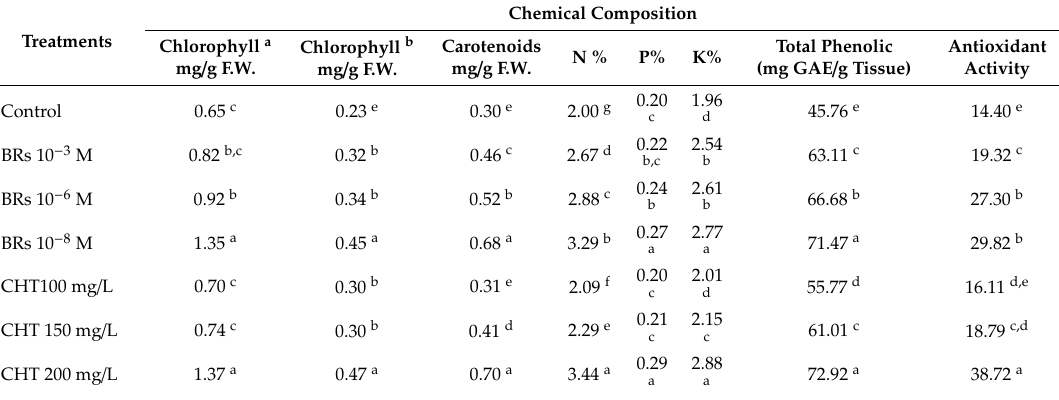
Table 5. E ff ects of di ff erent concentrations of brassinosteroids and chitosan on the chemical composition of Solidago canadensis L cv. Tara; the values are the mean of two